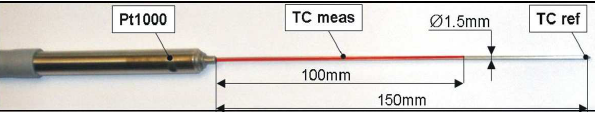
Fig. 2. The custom-made LNP-sensors fabricated by Hukseflux for use on planetary surfaces like on Moon or Mars. They are heated over thewholelength.